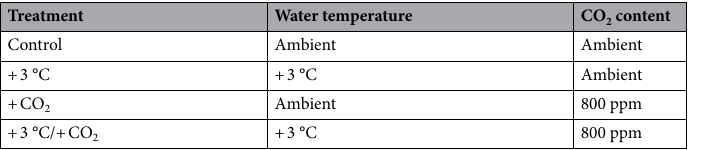
Table 3. Climate change treatments established in mesocosms. Each treatment was replicated three times (n = 3) in independent